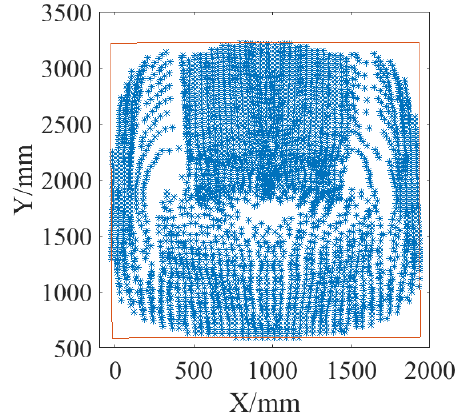
Figure 26. The minimum envelope rectangle.